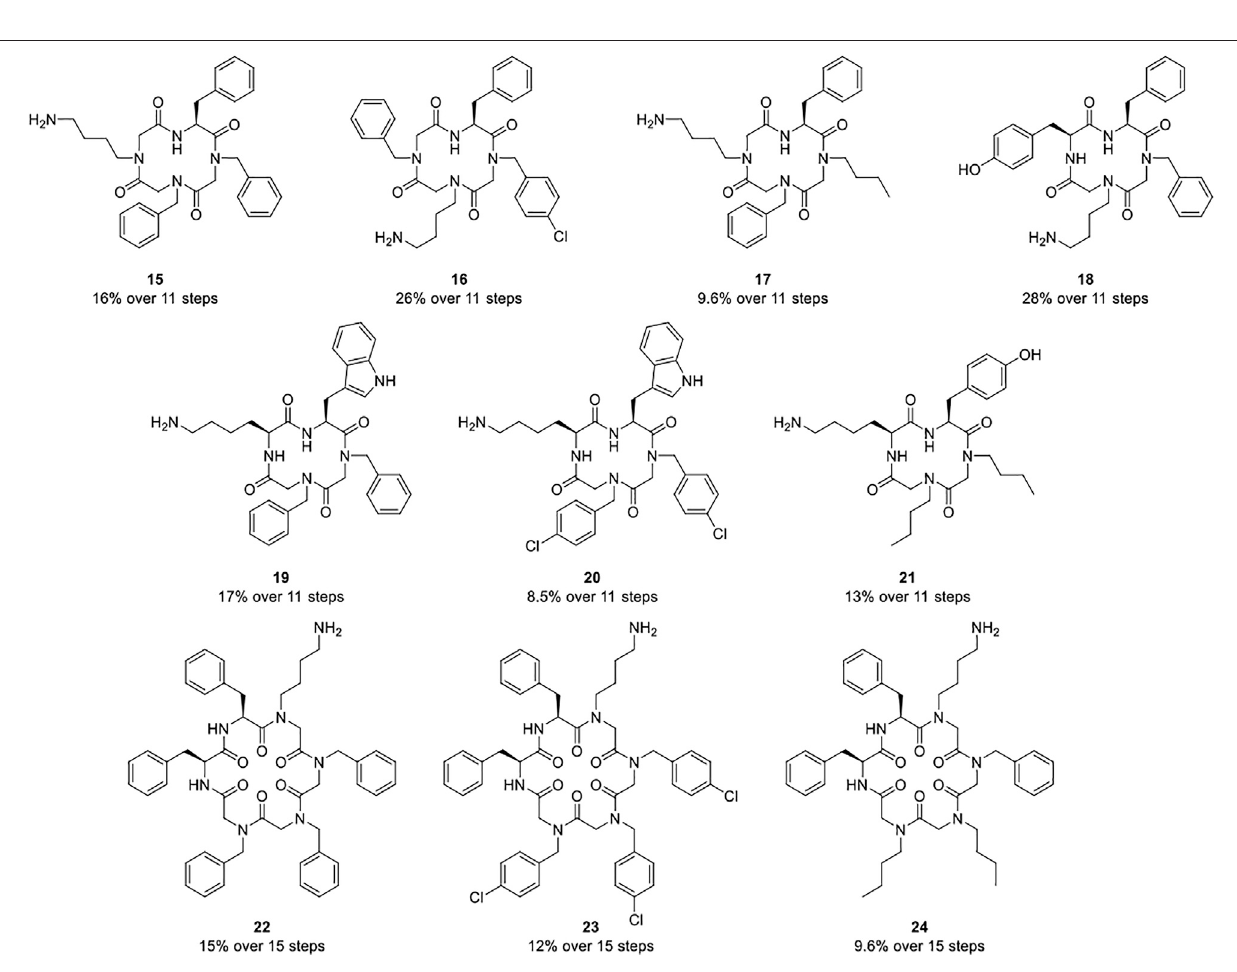
Frontiers in Chemistry |